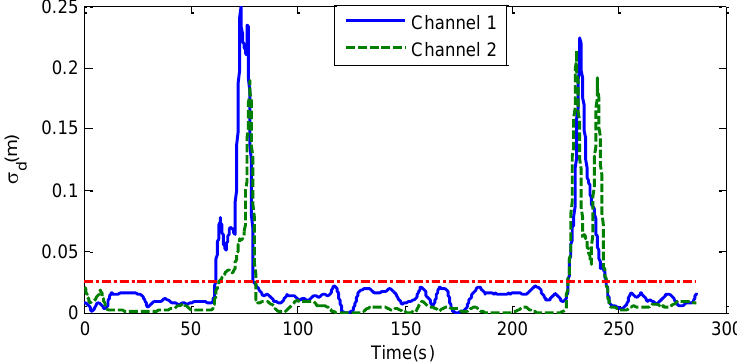
Figure 13. Results for a subject with simulated periods of apnoea and random body movements (case Figure 6e,f), channel 1 (left), and channel 2 (right). For the channel 1: ( a ) Breathing signal, ( b ) recorded signal from a microphone, ( c ) , movement index (solid line) and breathing index (dashed line), ( d ) periodogram obtained from channel 1. For the channel 2: ( e ) Breathing signal, ( f ) recorded signal from a microphone, ( g ) movement index (solid line) and breathing index (dashed line), ( h ) periodogram obtained from channel